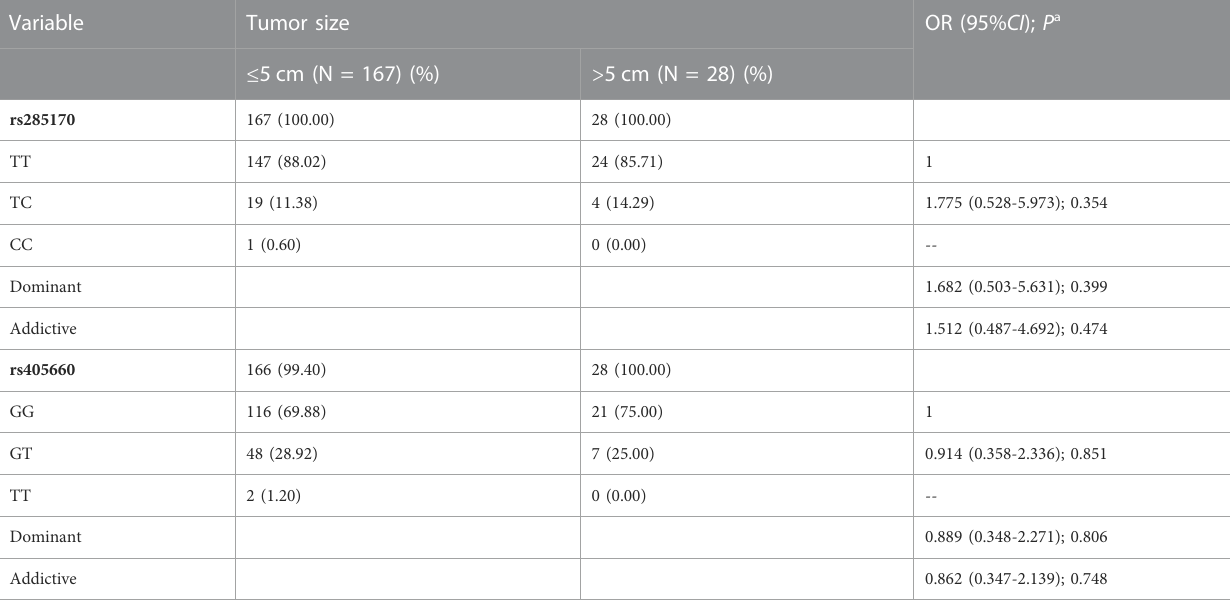
TABLE 5 Association of MYBL2 AS-related genetic variants with TNBC T staging.